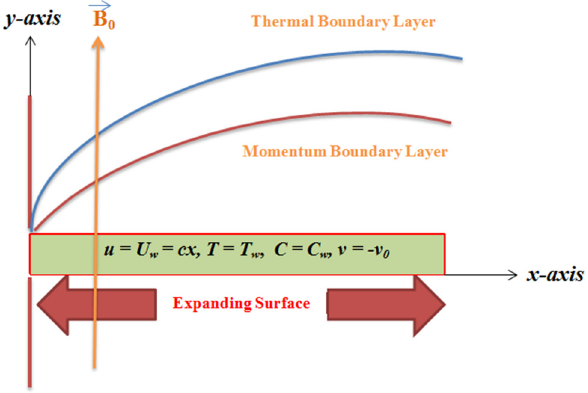
Figure 1: Structure of